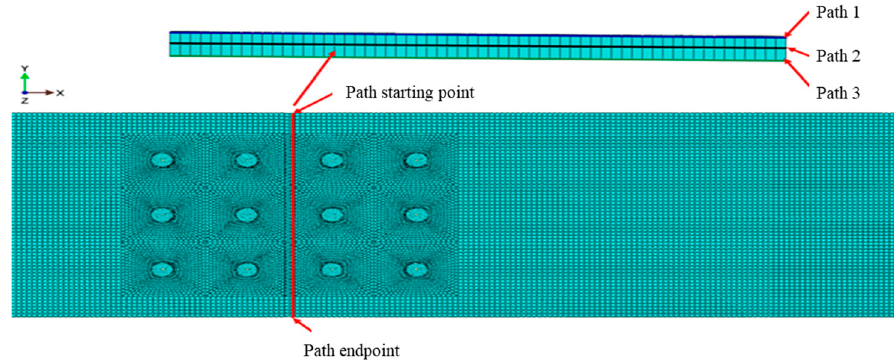
Figure 9. Path location of sheet boundary.